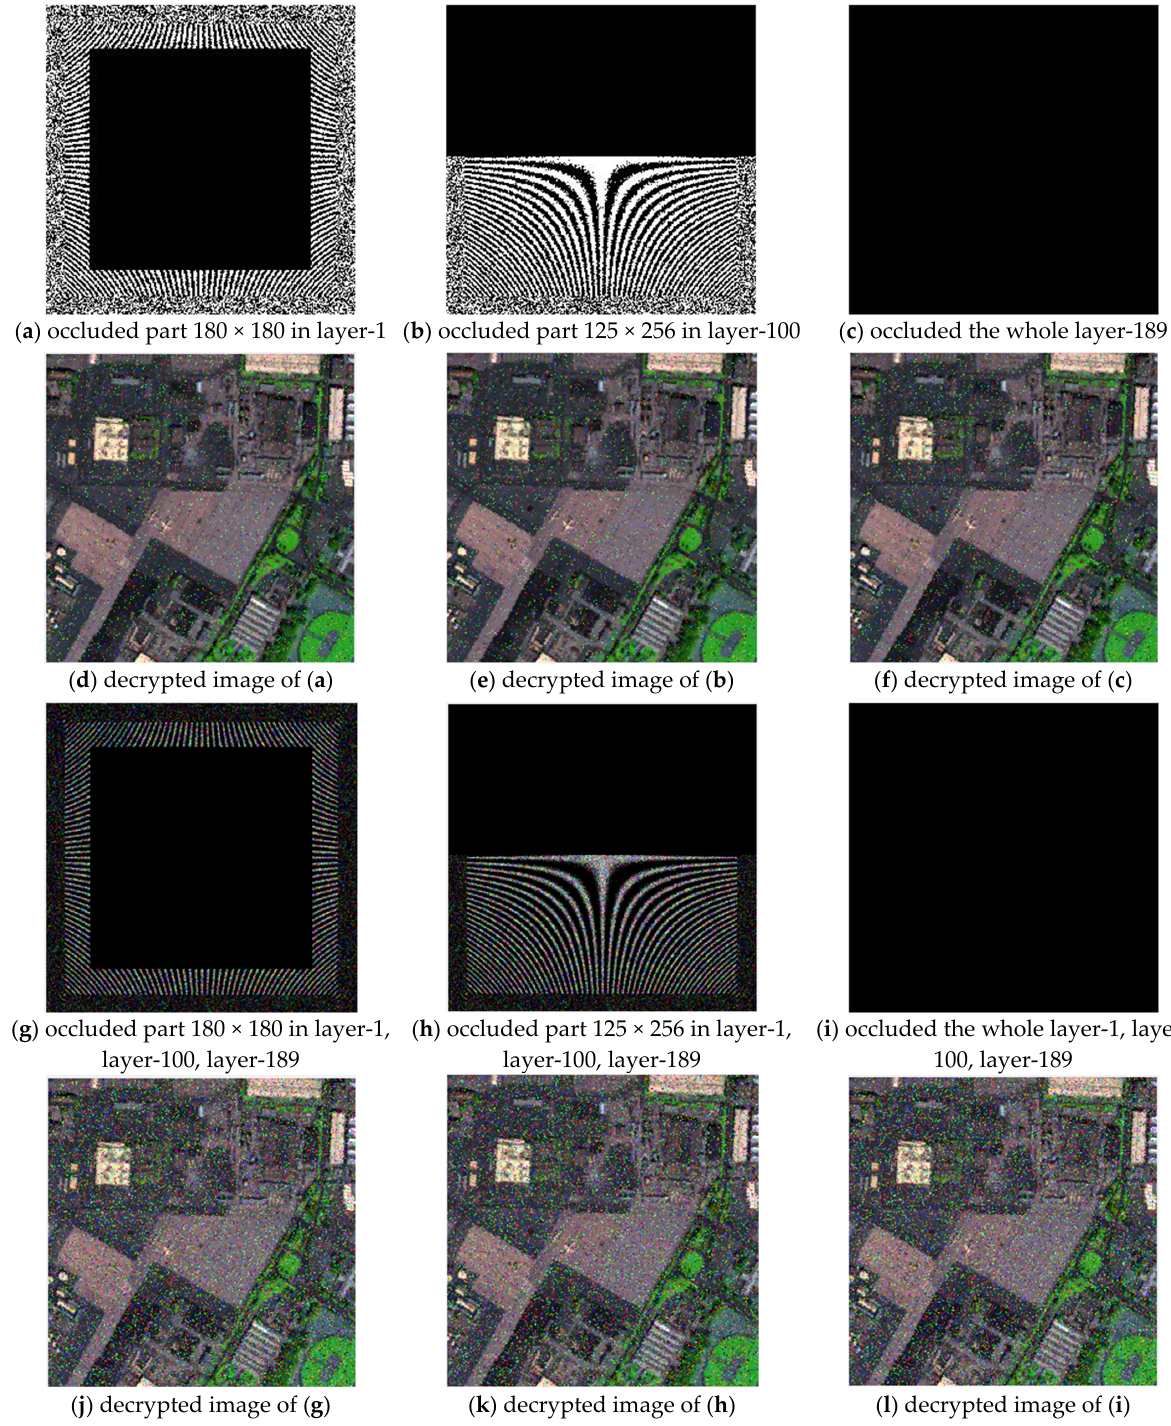
Figure 12. The test of occlusion attack: ( a – c ) the occluded cipher text of layer-1, layer-100 and layer- 189 respectively; and ( d – f ) corresponding decrypted image; ( g – i ) the occluded cipher text of the three layers; and ( j – l ) corresponding decrypted image.